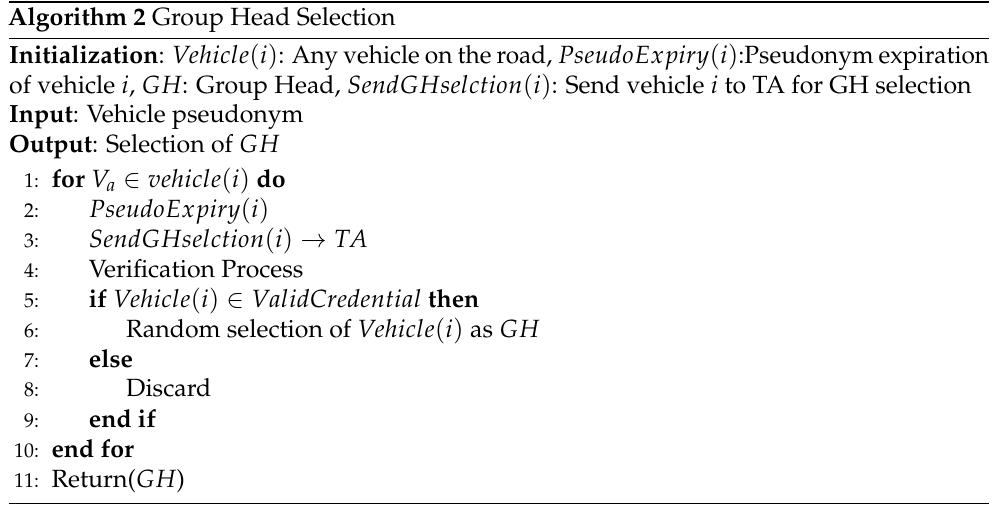
Algorithm 2 Group Head Selection